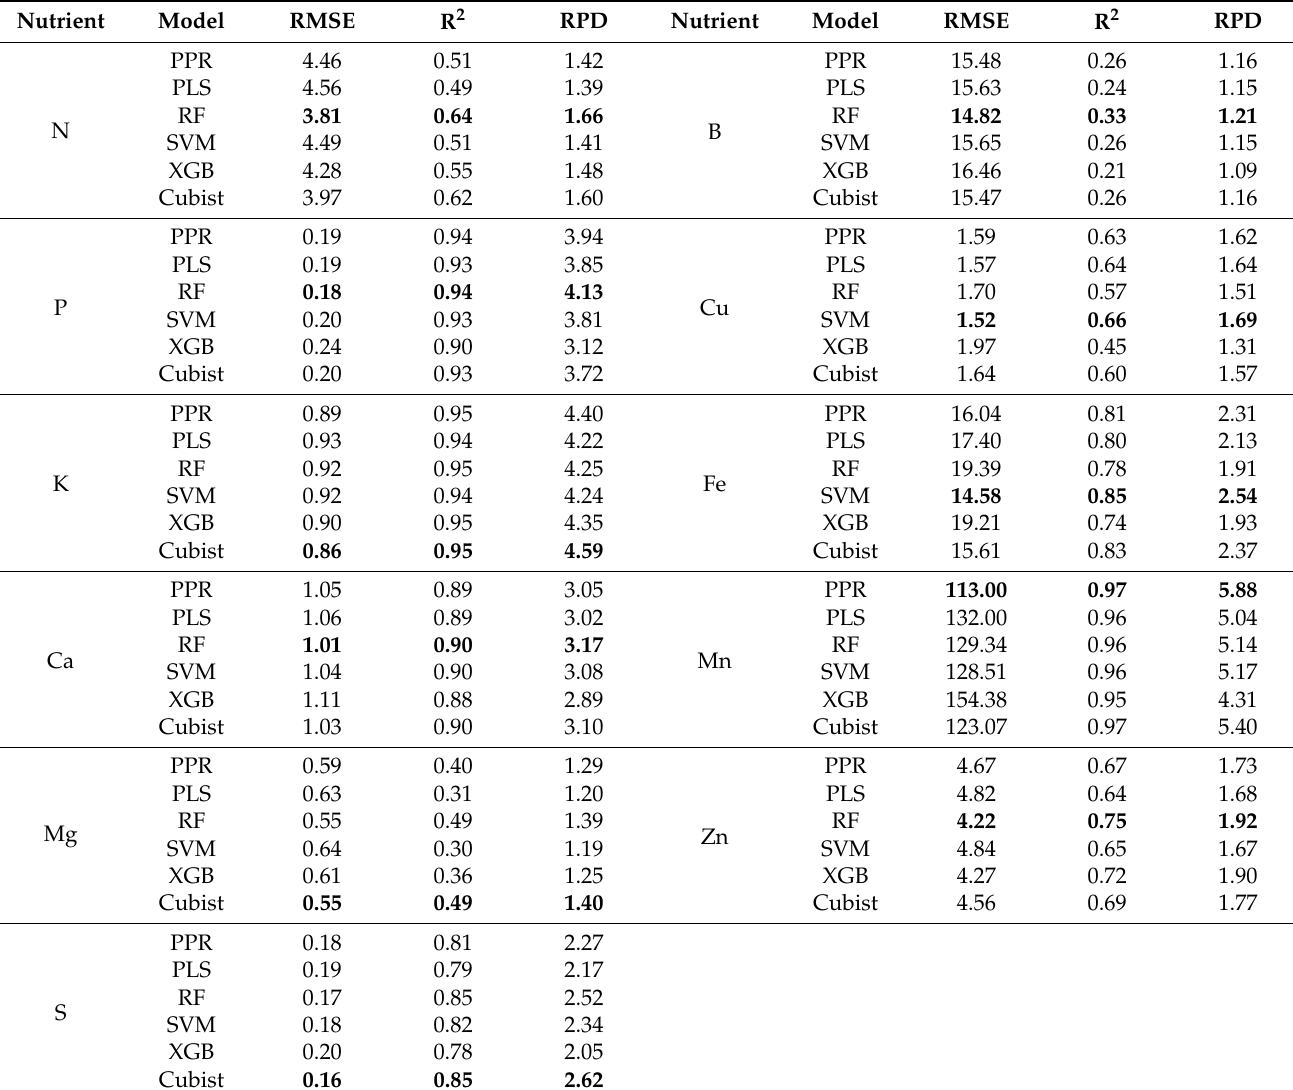
Table 3. Root mean square error (RMSE), coefficient of determination (R 2 ), and residual prediction deviation (RPD) for macro and micronutrients prediction models of Eucalyptus spp. leaves based on portable X-ray fluorescence (pXRF) elemental